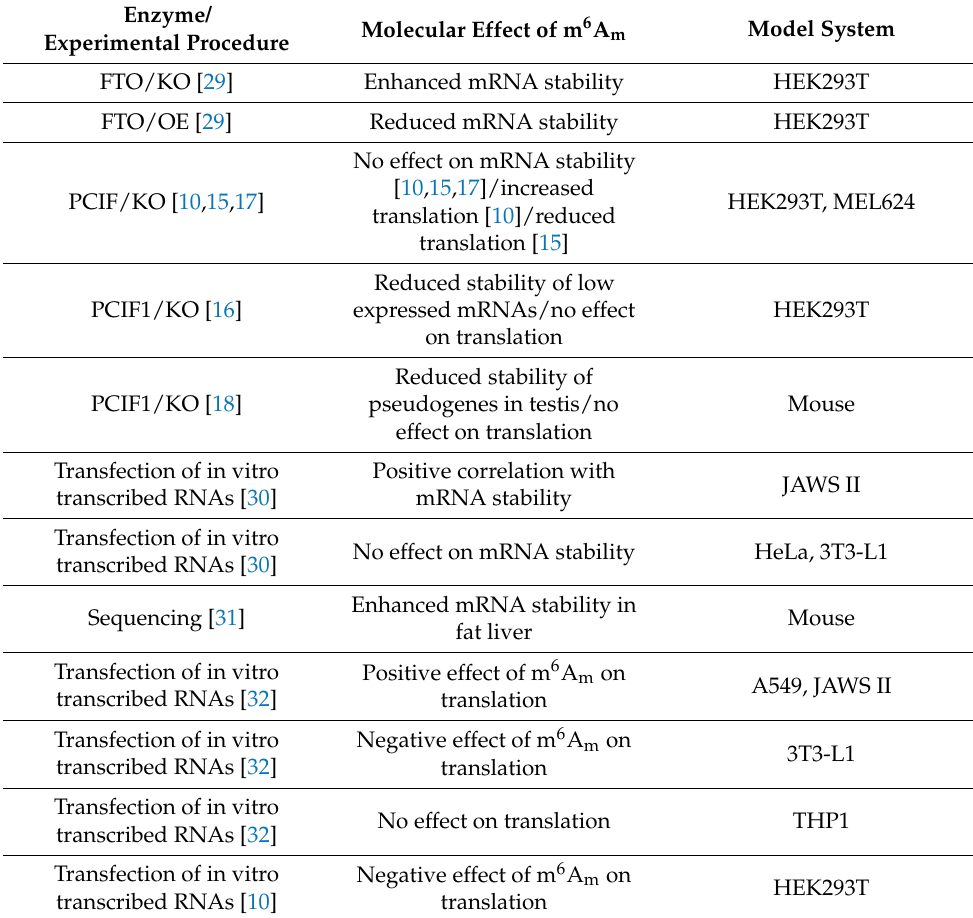
Table 2. Effects of m 6 A m in mRNA stability and